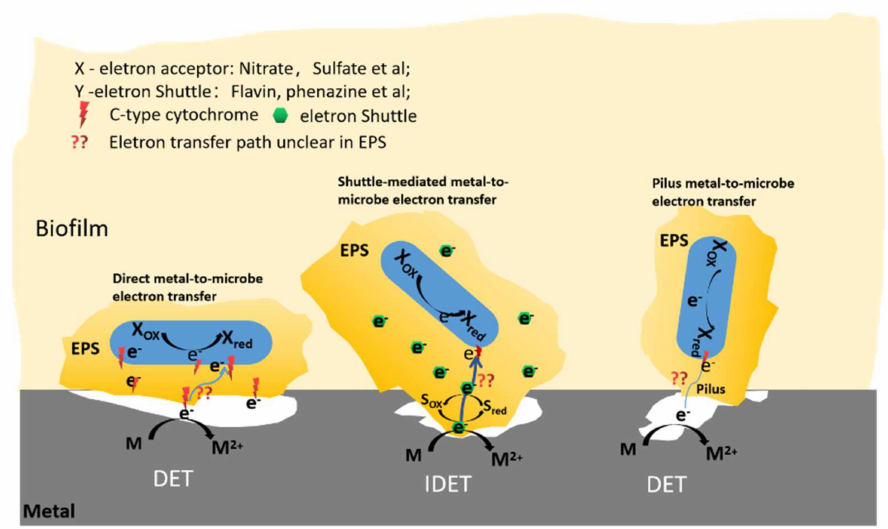
Figure 2. A hypothetical electron transfer pathway in presence and absence of EPS. DET, direct electron transfer; IDET, indirect electron transfer. Adapted from [78].